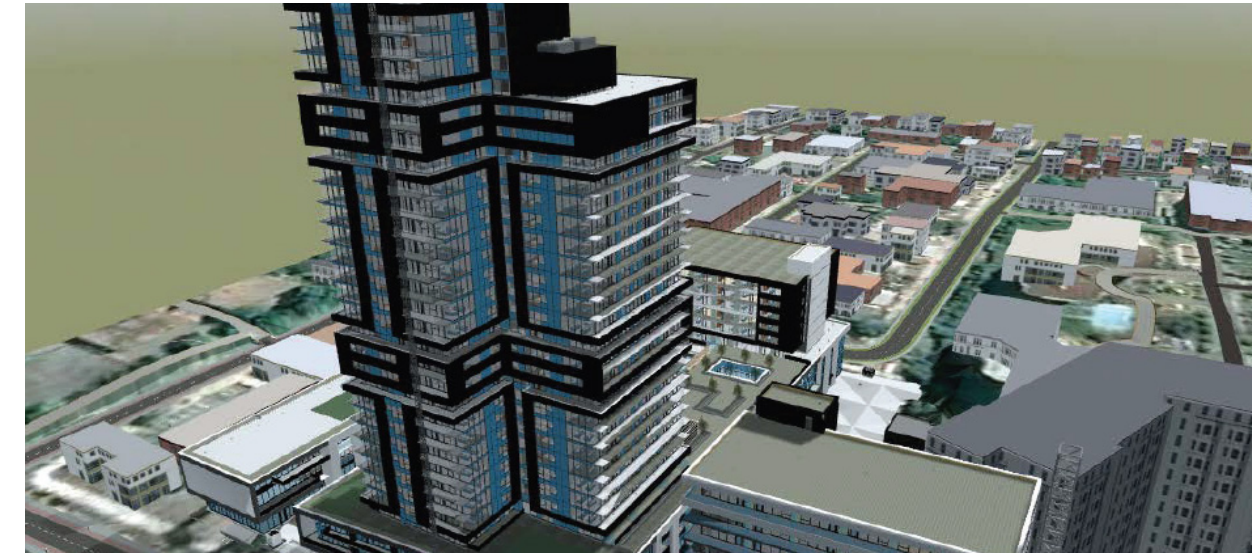
Figure 2. Project case rendering.